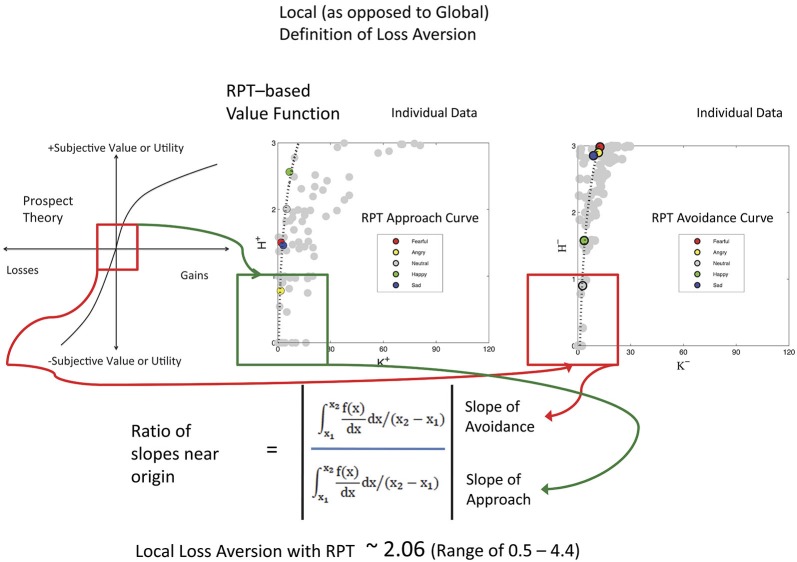
Local Loss Aversion Computation. This study used a local rather than a global assessment of loss aversion, meaning that the ratio was computed using the slopes around the inflection point for each graph, rather than the entire graph (Abdellaoui et al., 2007). In this figure, the same cartoon for prospect theory used in Figure 3 is shown on the left, with a red box around the inflection point between the positive and negative graphs that meet at the origin. The approach KH graphs (variables defined in Figure 3 legend) and avoidance KH graphs for the 17 subjects are shown as unfitted points in gray to the right. One example subject is shown with color points as defined in each graph with a fitted curve. The lowest 10% of these curves was then used for assessing the slopes as shown in the mathematics at bottom. Of interest, the LA value for these subjects approximates that reported by Tversky and Kahneman (1992).